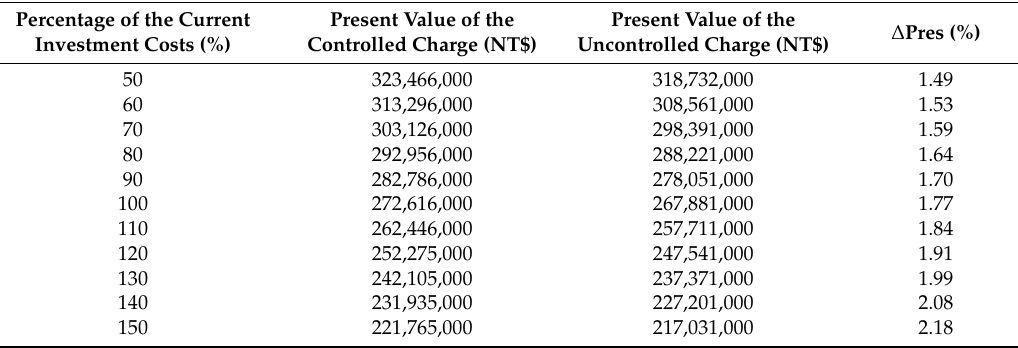
Table 8. Detailed sensitivity results of the investment cost parameter.